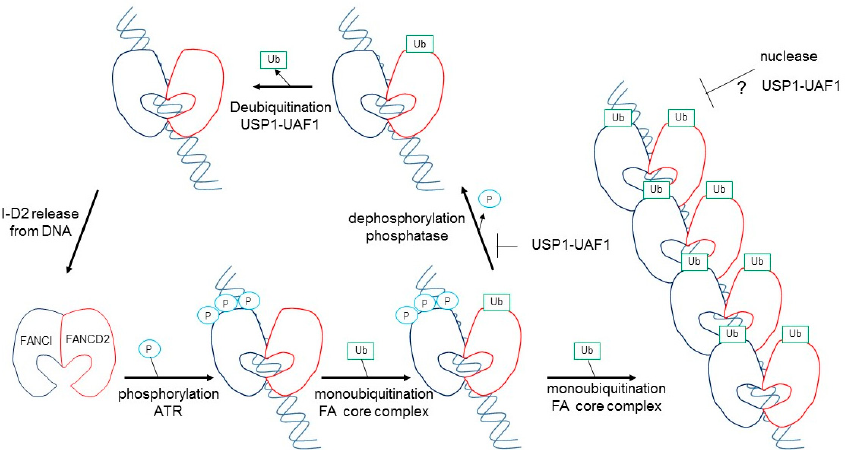
Figure 3. Proposed activation model of the FANCD2–FANCI complex by phosphorylation and monoubiquitination. See details in the text. This model was constructed according to the results of Tan et al. [28,30].